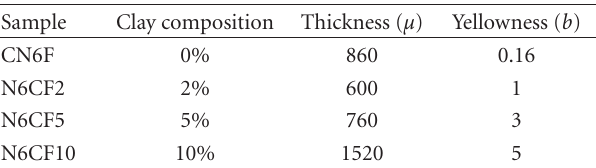
Table 1: Nylon 6 sample